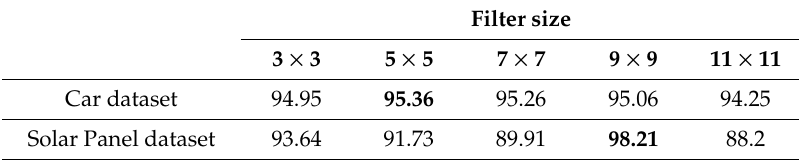
Table 1. Analysis of the filter size of the Conv layer versus the accuracy (in %): Left: Car dataset, Right: Solar Panel dataset.